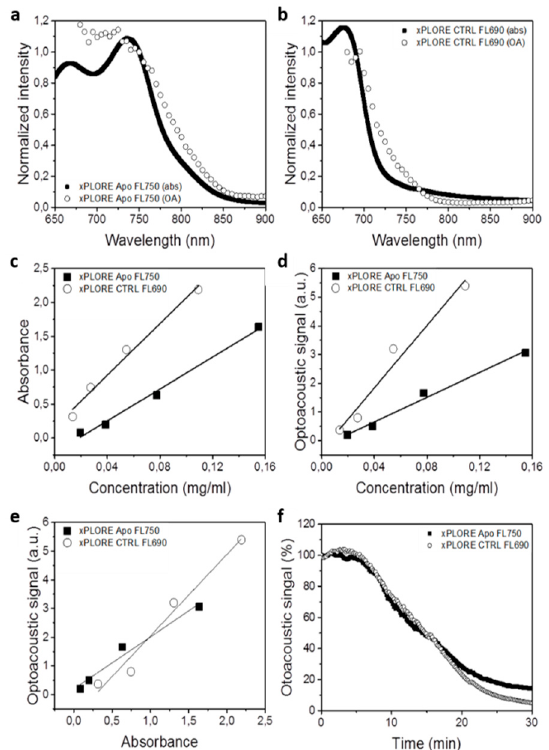
Figure 1. In vitro performance of xPLORE-Apo-FL750© and xPLORE-CTRL-FL690© as optoacoustic contrast agents. Normalized optical absorbance (abs) and normalized optoacoustic (OA) signal of ( a ) xPLORE-Apo-FL750© and ( b ) xPLORE-CTRL-FL690© at 650–900 nm light wavelength range. ( c ) Correlation between concentration and optical absorbance for each probe. ( d ) Correlation between concentration and optoacoustic signal for each probe. For all measurements shown in panels ( c , d ), the probes were superficially injected in agar phantoms and illuminated at 700 nm. ( e ) Optoacoustic signal for each probe as a function of optical absorbance. ( f ) Photobleaching of each probe over time.